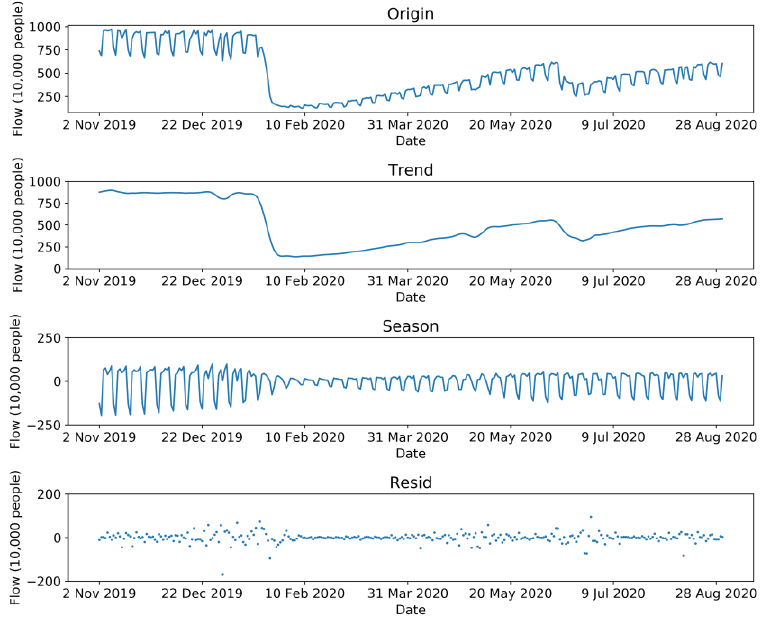
Figure 5. STL decomposition results of bus passenger flow.